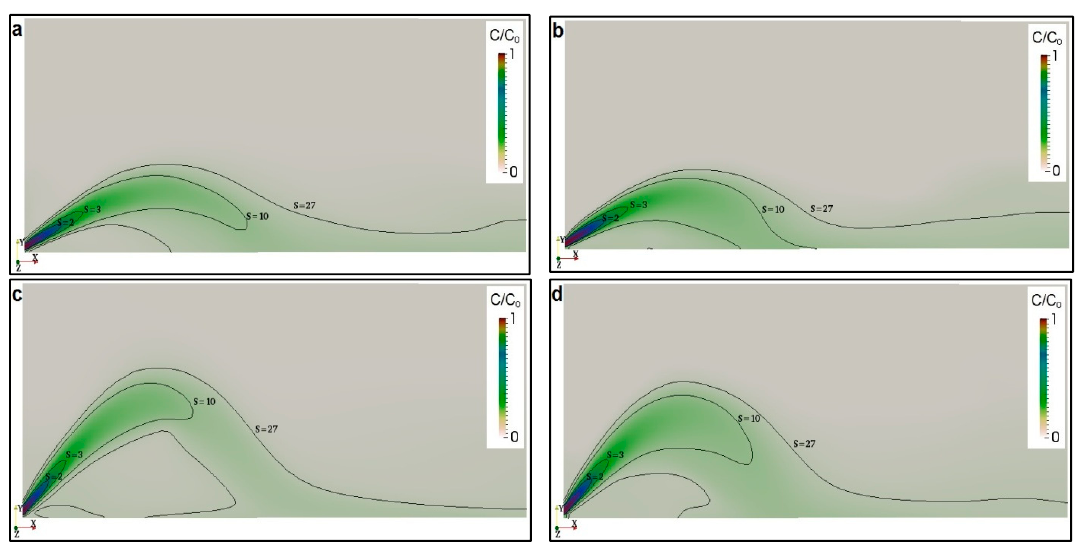
Figure 3. Mixing regimes for 30° and 45° inclined dense jets. ( a ) 30°, realizable k- ε ; ( b ) 30°, LRR; ( c ) 45°, realizable k- ε ; ( d ) 45°, LRR (Source: [25]).